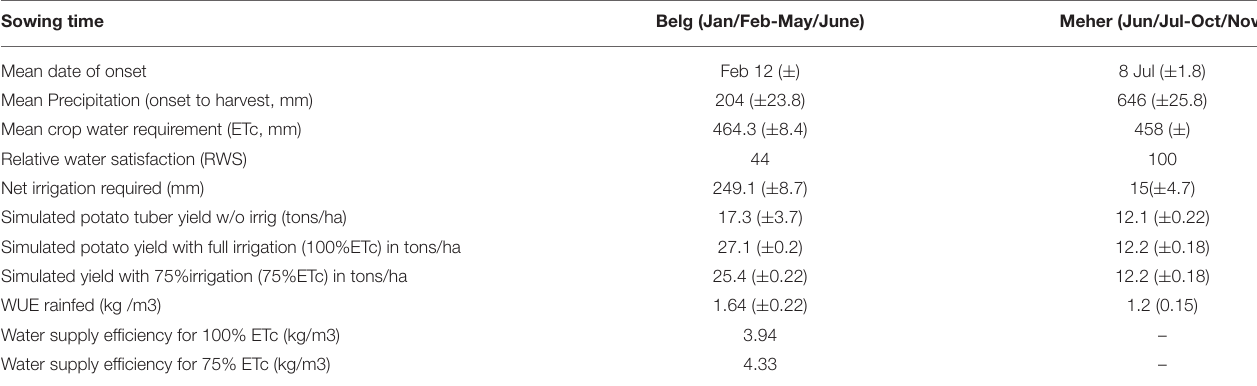
TABLE 5 | Mean precipitation, water requirement (ETc), relative water satisfaction (RWS) from the natural rainfall based on long-term weather data (2001–2020) and net irrigation requirement of the potato crop during the small rainfall (Belg) and main rainfall (Meher) seasons at Barneb 2 small-scale irrigation scheme in Northeastern Ethiopia.